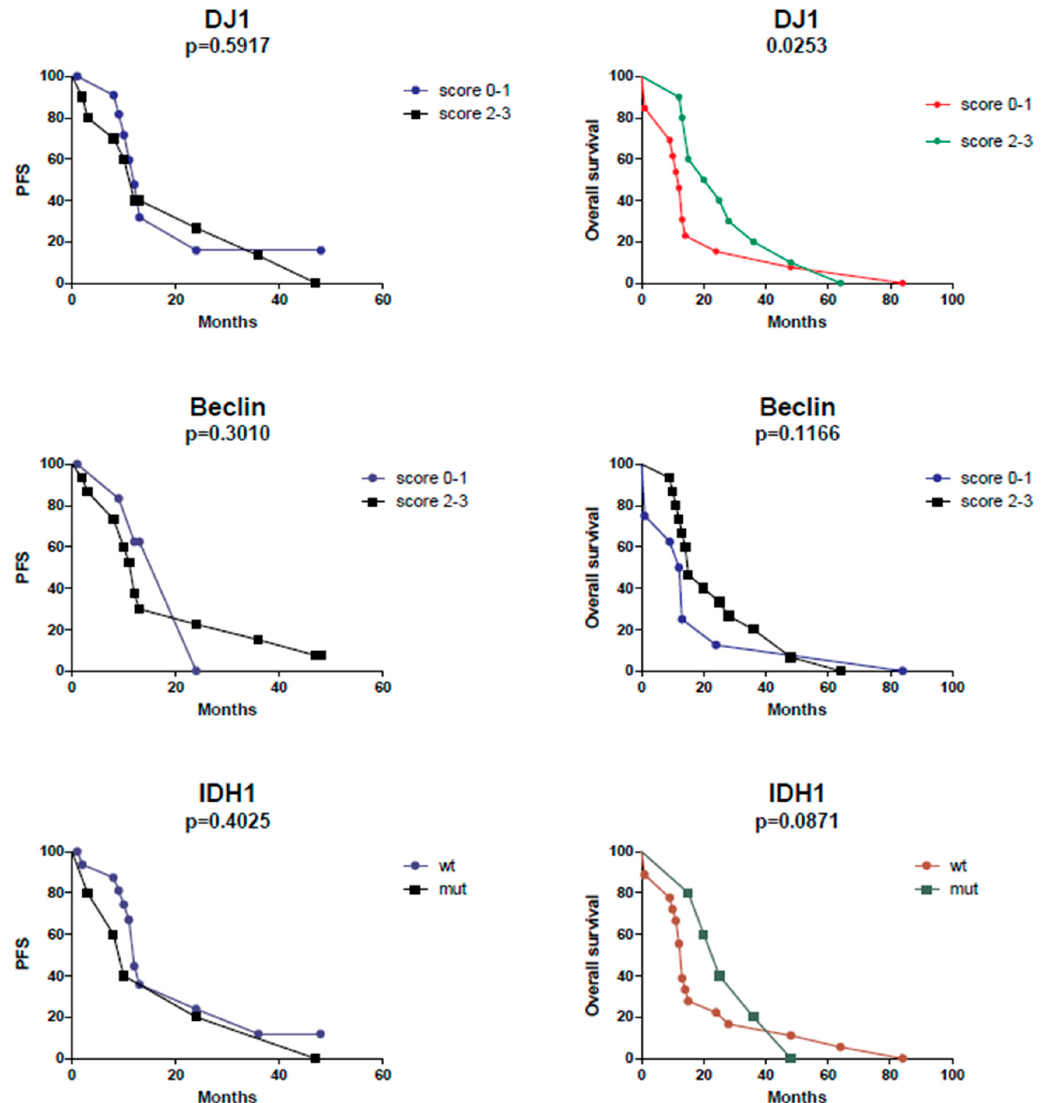
Figure 5. Cases with a DJ-1 score of 2 and 3 and cases showing IDH mutation showed longer